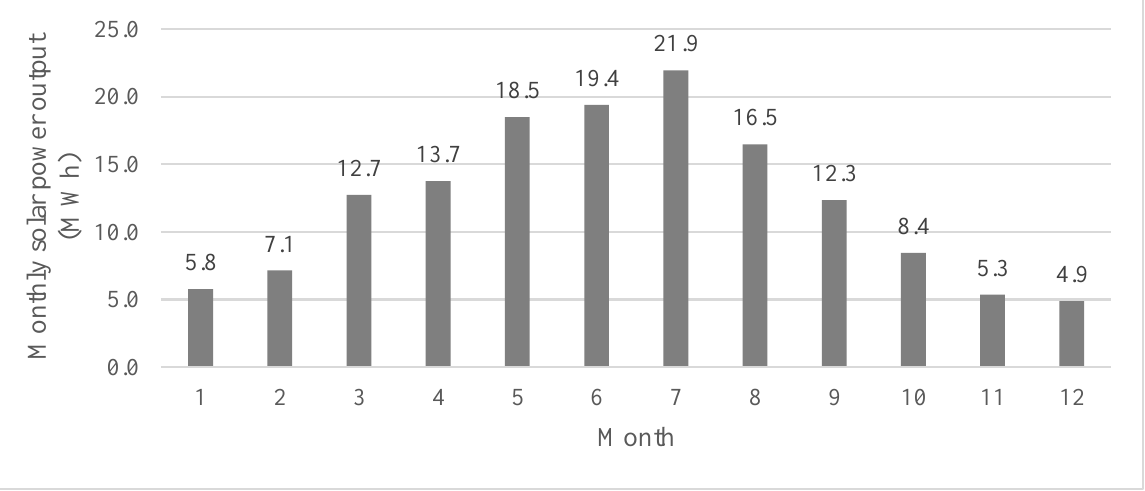
Figure 5. Monthly solar energy output from a 75,600 W Canadian Solar CS6X_300P solar panel array in Pincher Creek 2017(CWEEDS).